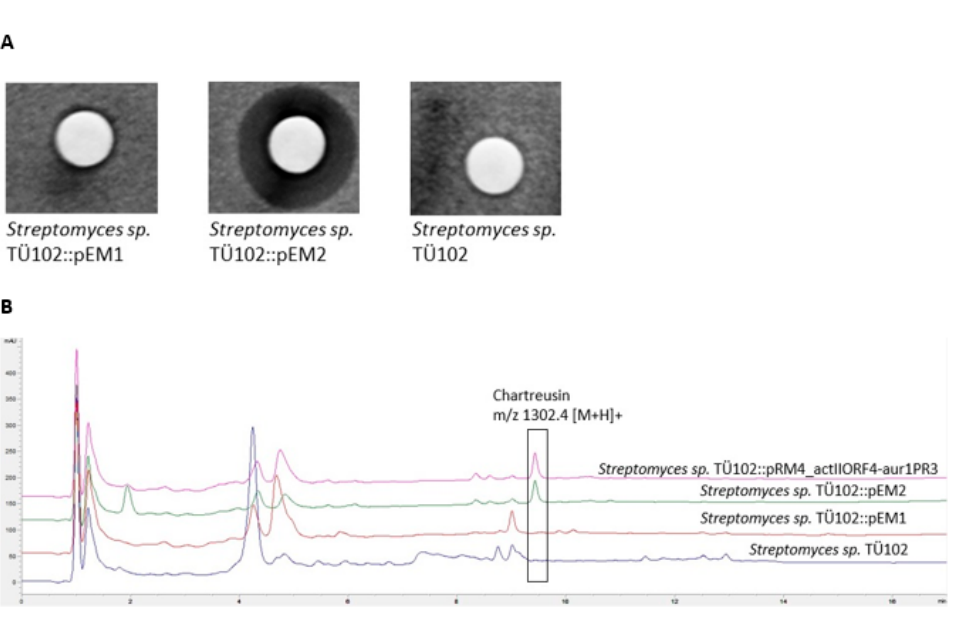
Figure 3. Analyses of the extracts of S. sp. TÜ102 wild type and recombinant strains. ( A ) Bioassay analysis of S. sp. TÜ102 and the recombinant strains S. sp. TÜ102::pEM1, S. sp. TÜ102::pEM2 and S. sp. TÜ102. Indicator strain Bacillus subtilis; 10 µL of the extracts were spotted of each culture on filter disc (1 mL ethylacetate extract was evaporated and dissolved in 100 µL methanol). Inhibition zone of S. sp. TÜ102::pEM2 ø 1 cm. ( B ) HPLC/MS analysis of S. sp. TÜ102 and the recombinant strains S. sp. TÜ102::pEM1, S. sp. TÜ102::pEM2, S. sp. TÜ102 and S. sp. TÜ102 pRM4_actIIORF4-aur1PR3. A peak with m/z 1302.4 [M+H] + , corresponding to chartreusin, was only detected in the recombinant strains S. sp. TÜ102::pEM2 and S. sp. TÜ102 pRM4_actIIORF4-aur1PR3.